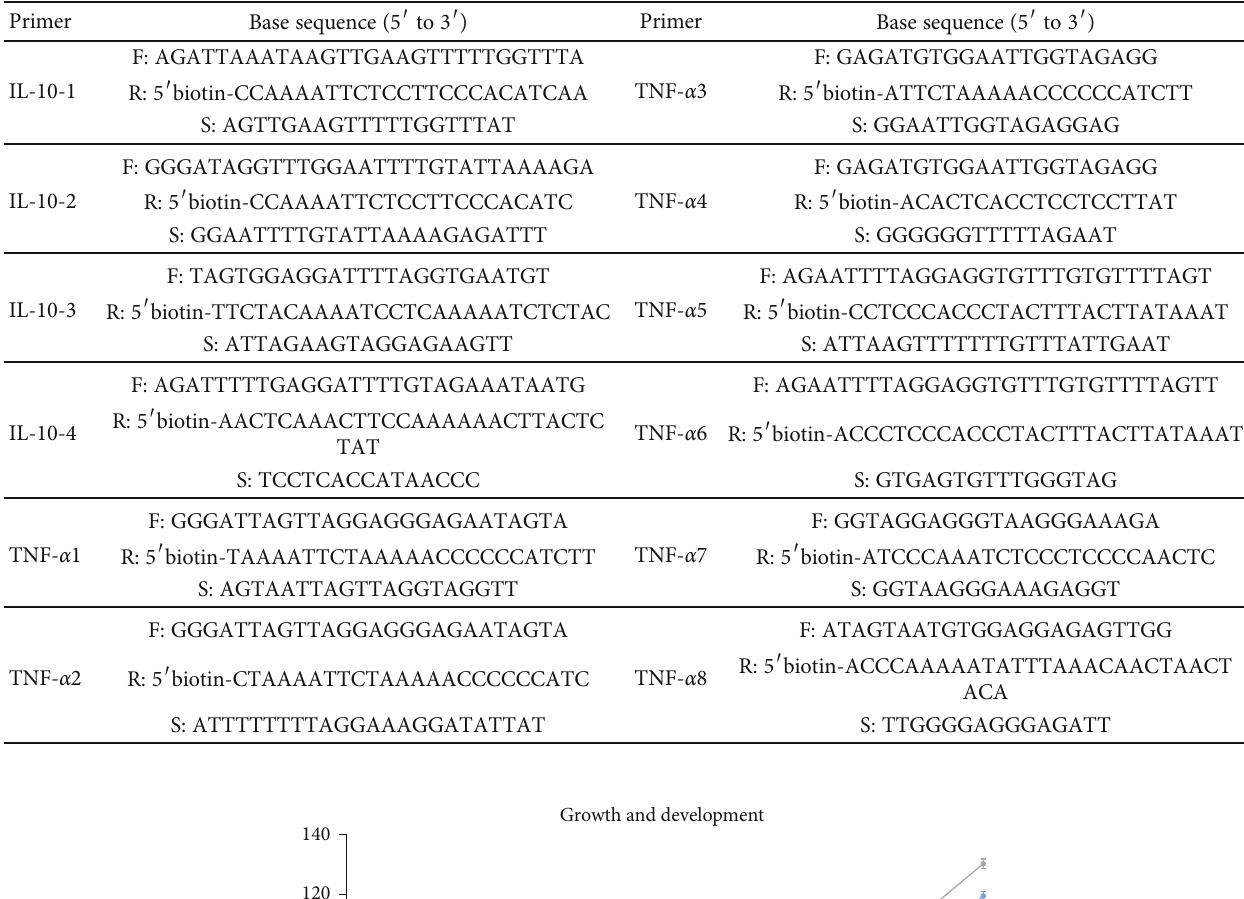
Table 2: PCR primers and sequencing primers for CpG loci in the promoter region.